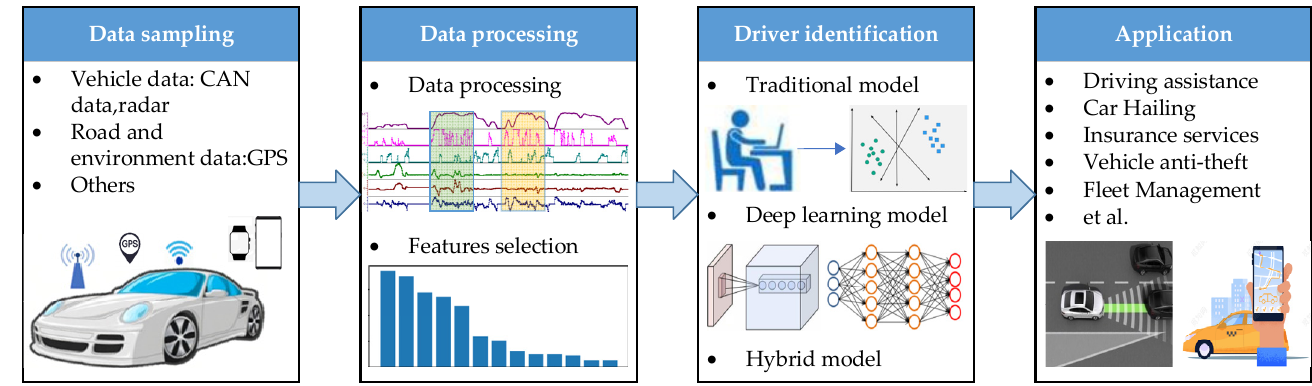
Figure 1. Basic process of driver identification task.